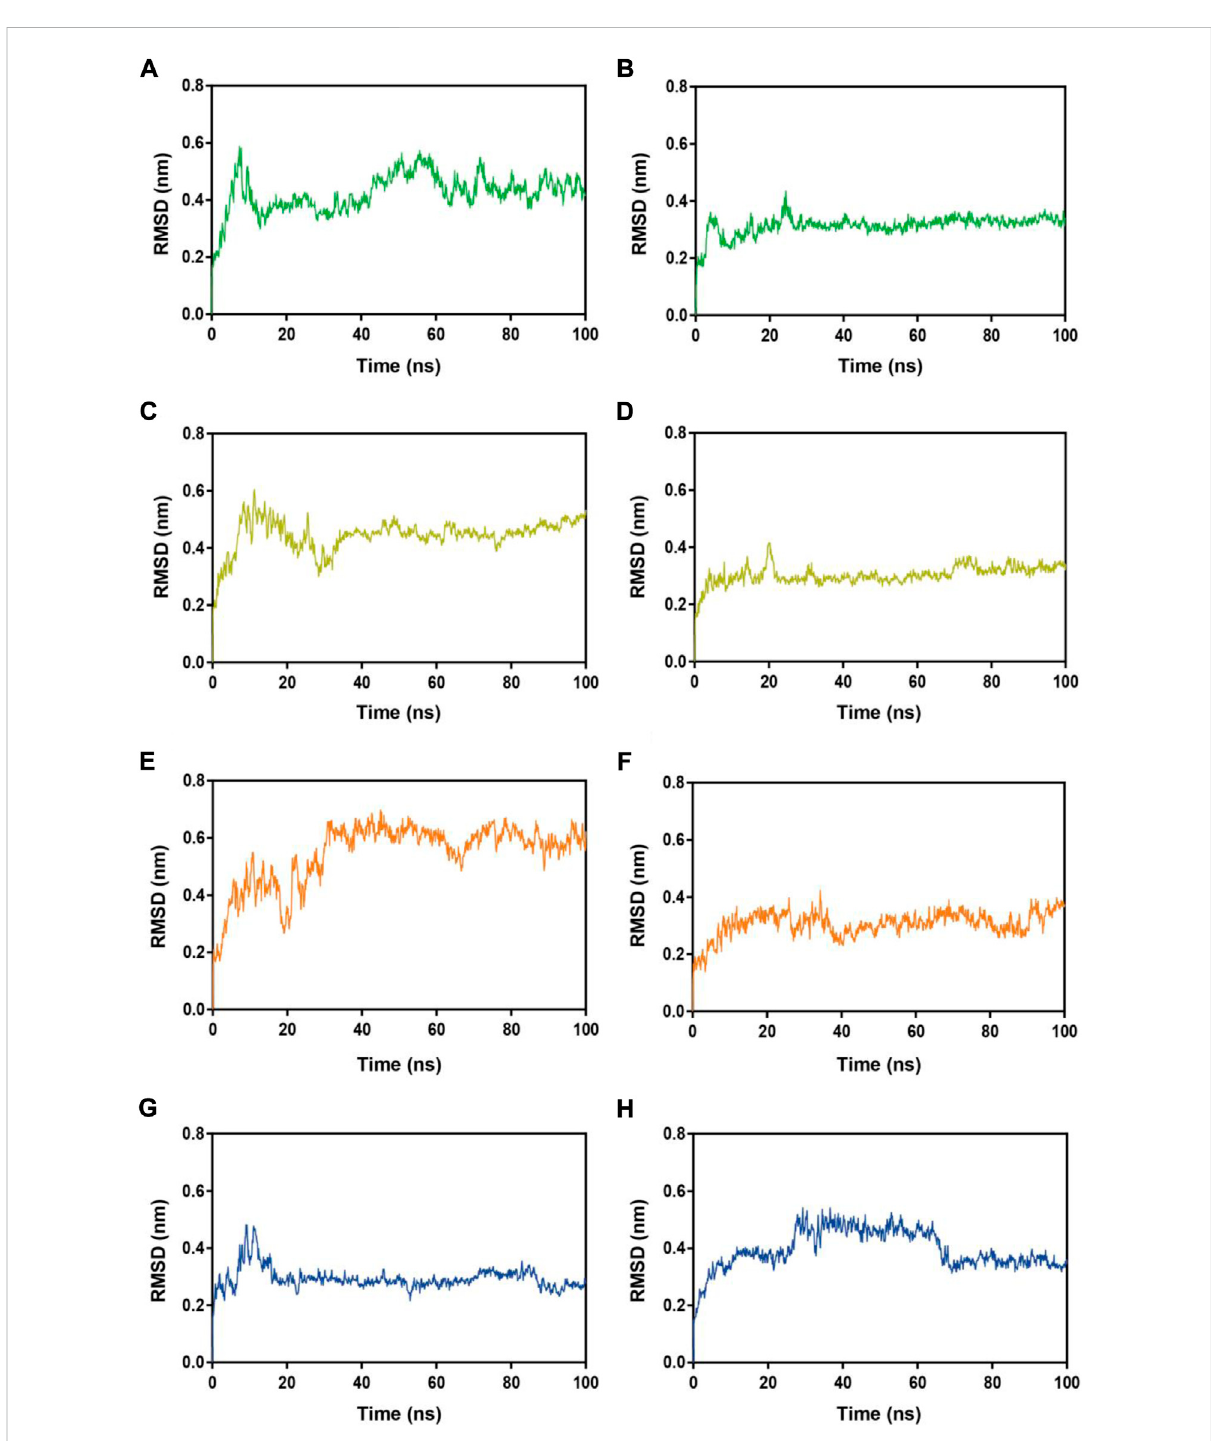
FIGURE 5 RMSDsofC α atomsduringMD-simulation. (A , B) MR-1incomplexwithMproandRBD,respectively; (C , D) MR-2incomplexwithMproandRBD, respectively; (E , F) MR-3 in complex with Mpro and RBD, respectively; (G , H) MR-4 in complex with Mpro and RBD,